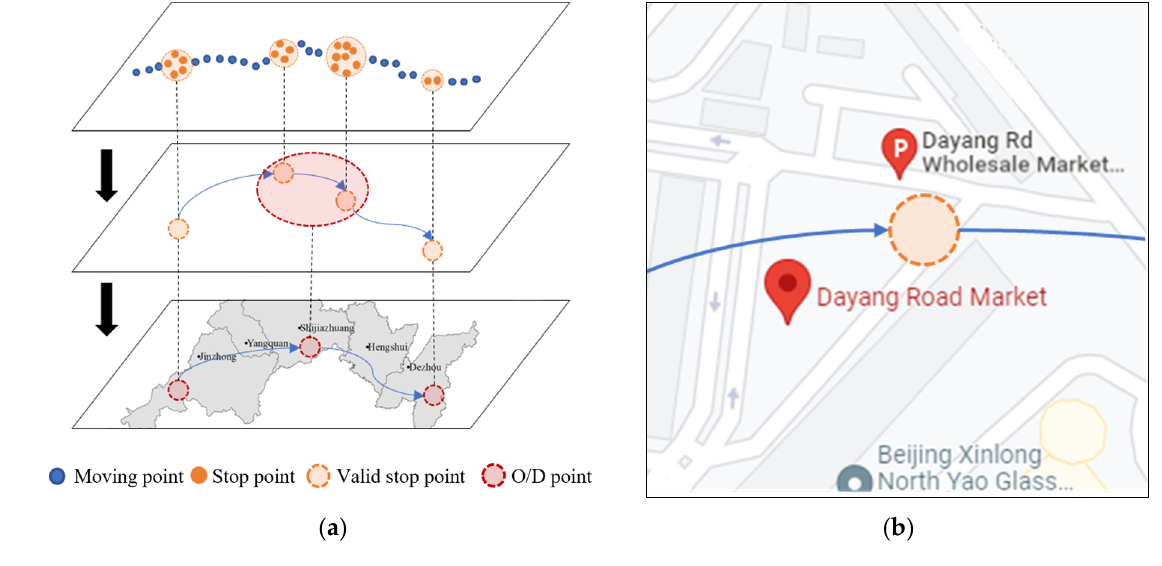
Figure 1. Illustration of data processing: ( a ) origin–destination sequence construction; ( b ) valid stop point and the surrounding POI/AOI. Table 1. Relationship between POI/AOI types and the purpose of freight